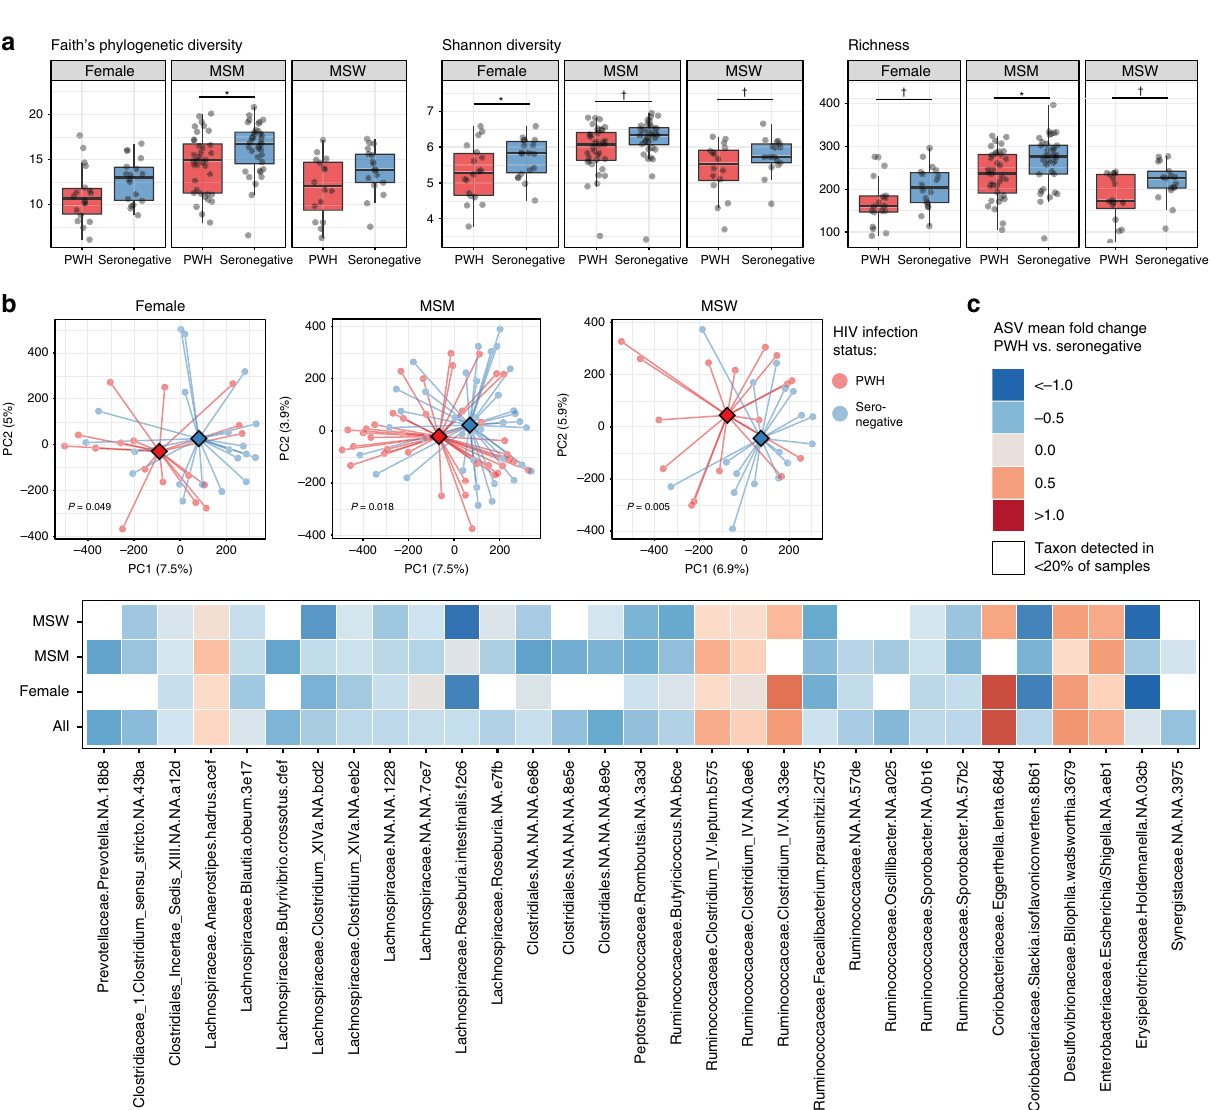
Fig. 2 Gut microbiota composition differences are evident within subgroups. a Alpha diversity measures are shown for the three sex/sexual practice subgroups ( n = 36 females, n = 72 MSM; men who have sex with men, n = 34 MSW; men who have sex with women), split by PWH and seronegative controls. Paired two-tailed t -tests were used to test signi fi cance of differences between groups ( P = 0.022, P = 0.048, P = 0.064, P = 0.061, P = 0.080, P = 0.022, P = 0.056, respectively, for those denoted with bar). Boxes denote inter-quartile range, bar denotes median, and whiskers denote range. b PCoA plot based on Canberra beta diversity metric with centroids depicted as diamonds for PWH and seronegative controls. Community differences were veri fi ed by PERMANOVA (Female P = 0.04998; MSM P = 0.005; MSW P = 0.018). c Tile plot showing mean fold change of ASVs among all PWH vs. seronegative participants, with representations of log mean fold change depicted per subgroup for signi fi cant ASVs. ASVs with Wilcoxon signed-rank signi fi cance P < 0.0125 in the comparison of PWH vs. seronegative among all paired participants together (including all three subgroups) are shown. White squares denote ASV being present in fewer than 20% of samples within the given subgroup. † P < 0.10, * P <